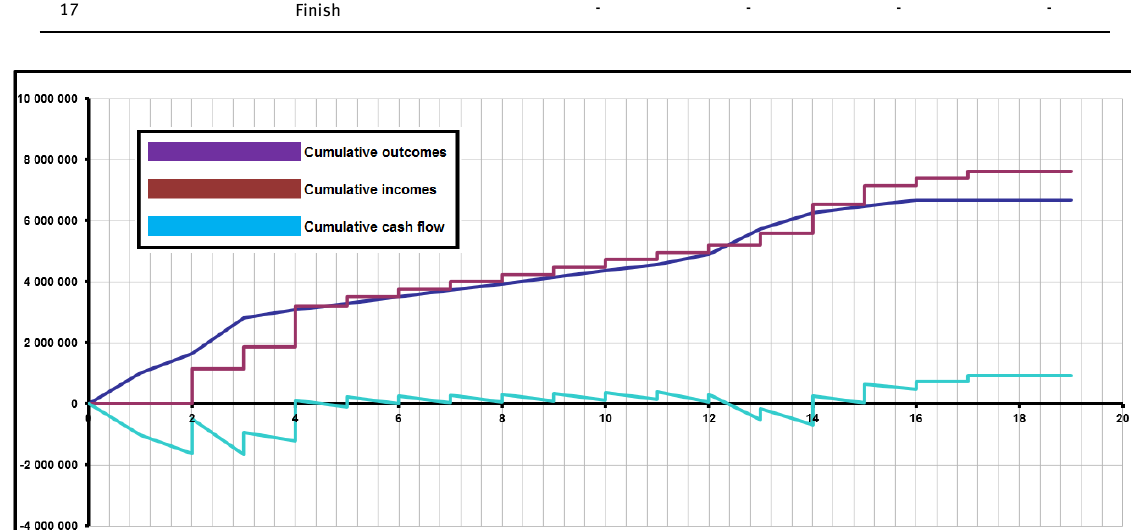
Figure 3: The cash flow for respective periods - the best result [USD]